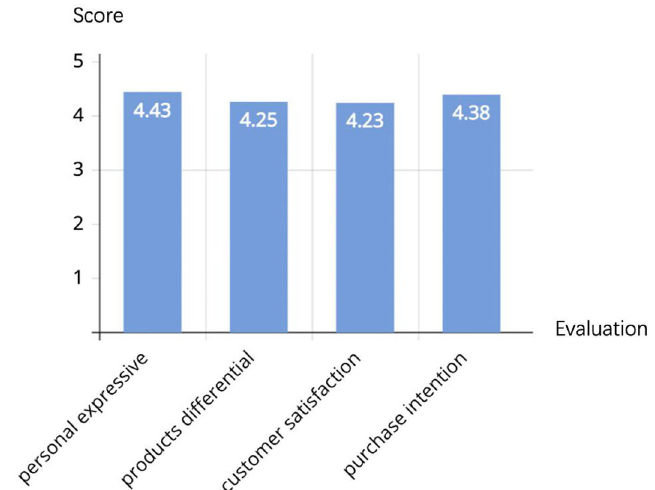
Fig. 9 The evaluation of personalized fashion